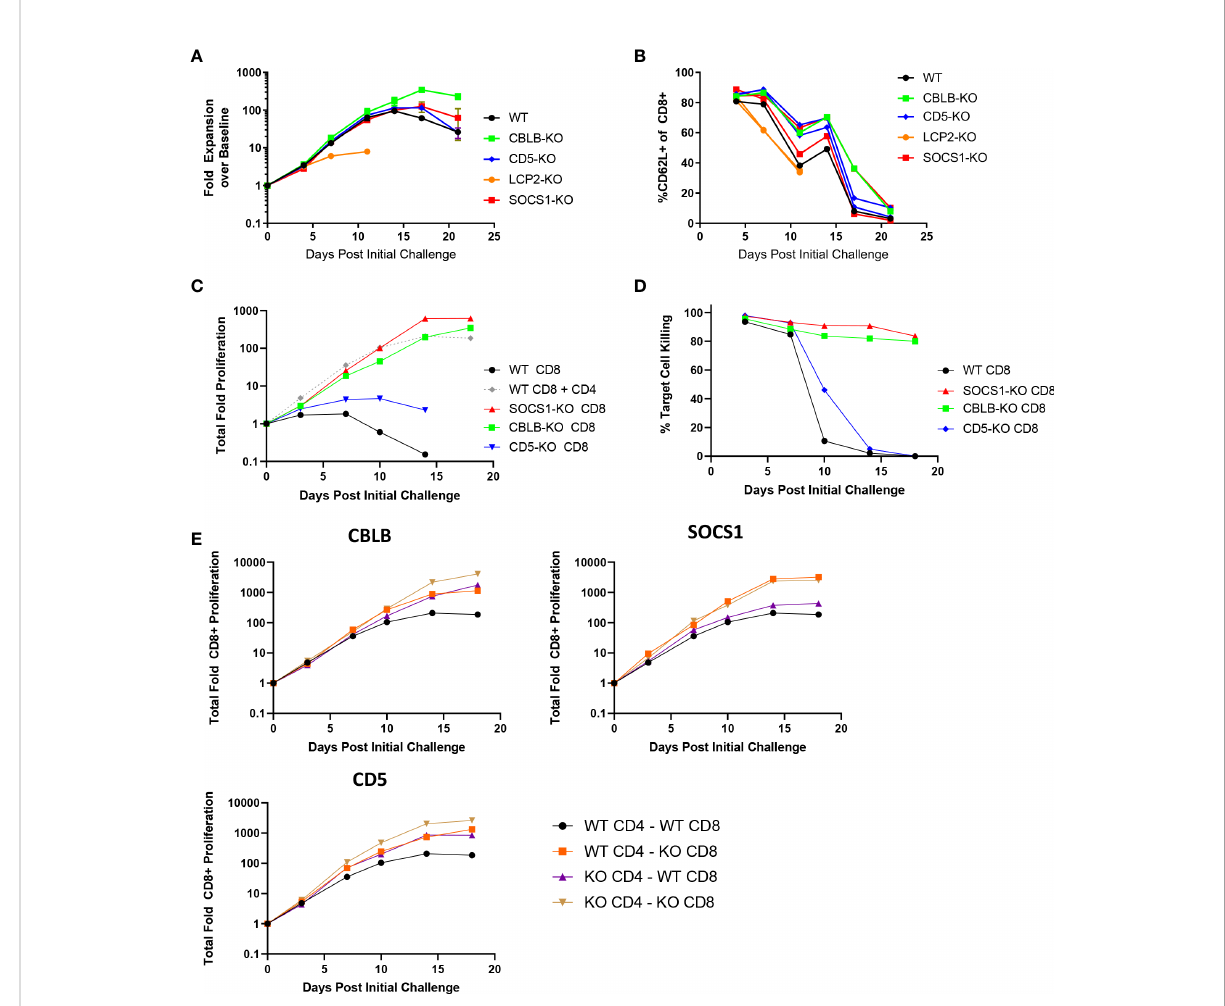
FIGURE 2 CBLB, CD5, and SOCS1 serve as negative regulators of CD4 and CD8 T cell responses to BsAb-mediated activation. A-B. A CRISPR/Cas9 approach was used to knock out the indicated genes in healthy donor T cells, after which a long term repeat challenge assay was performed as in Figure 1 for the indicated T cell populations. Cellular proliferation and CD62L-positivity were measured over time via fl ow cytometry. C-D. A CRISPR/Cas9 approach was used to knock out the indicated genes in puri fi ed CD8+ T cells, which were then used in a long term repeat challenge assay as above to monitor proliferation and target cell killing over time. All populations other than the gray dashed line in (C) correspond to CD8+ cells without access to CD4+ T cell help. E . The indicated genes were knocked out in both CD4+ and CD8+ T cells, which were then combined together to test cell-intrinsic and cell-extrinsic bene fi ts of the knockout of these three genes to the proliferation of CD8+ T cells, revealing that SOCS1 exclusively provided cell-intrinsic bene fi ts, whereas CBLB and CD5 knockout provided cell-intrinsic and -extrinsic bene fi ts. Experiments were repeated in duplicate using T cells from two